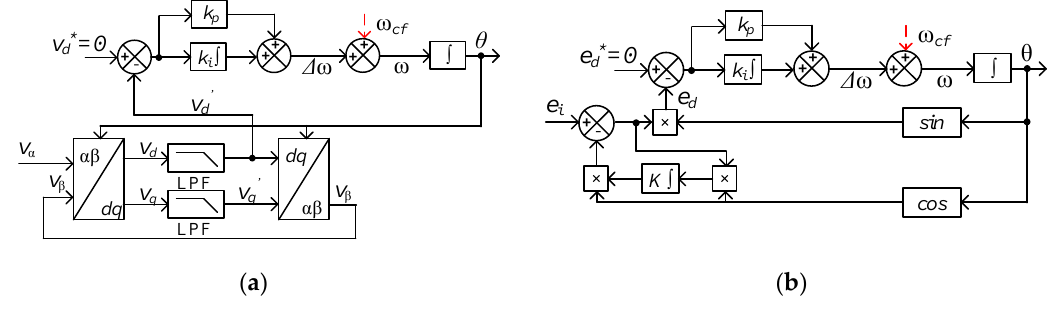
Figure 3. ( a ) Inverse Park’s PLL; ( b ) enhanced-PLL.